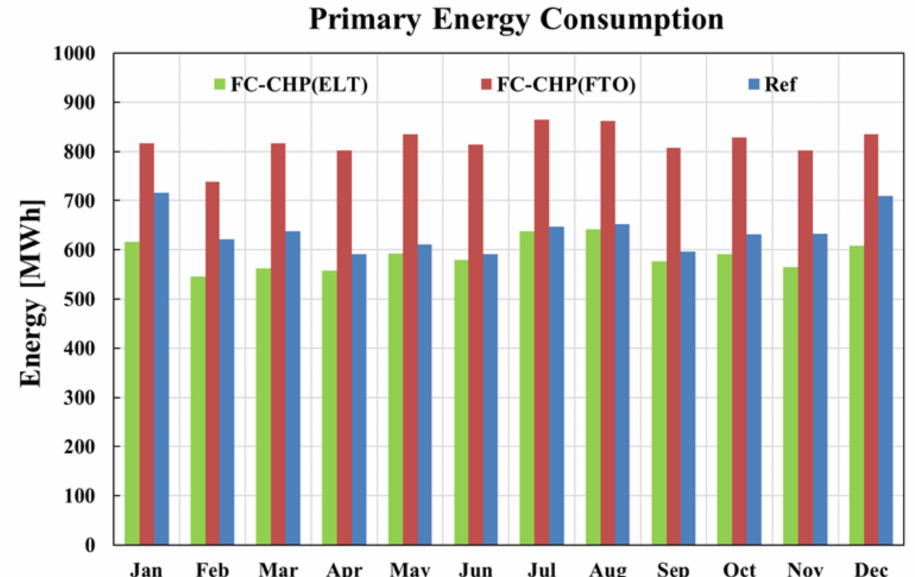
Figure 11. Primary energy consumption for the three case studies (ELT and FTO models in FC-CHP systems and the conventional energy supply